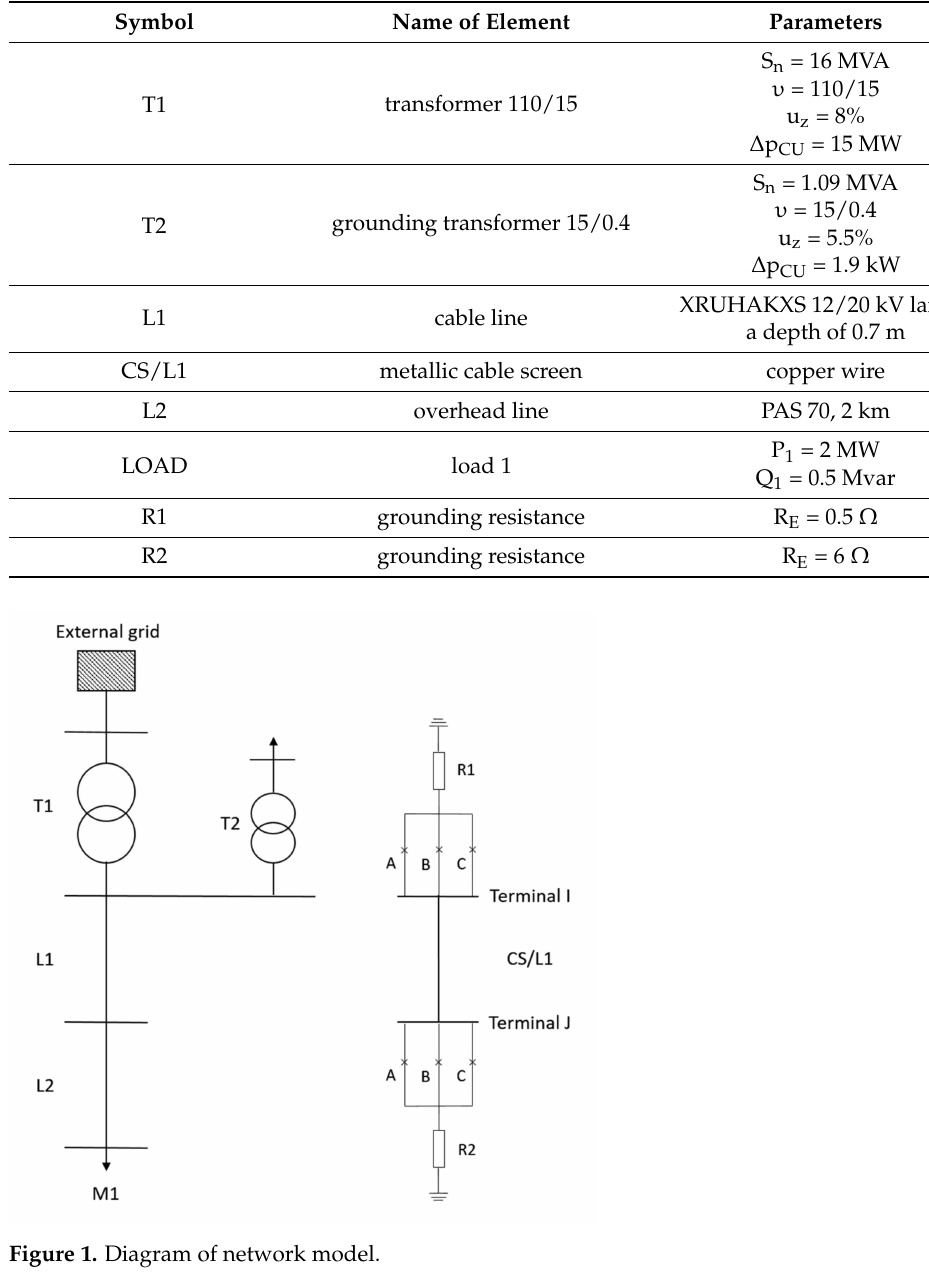
Table 1. Parameters of model’s elements.